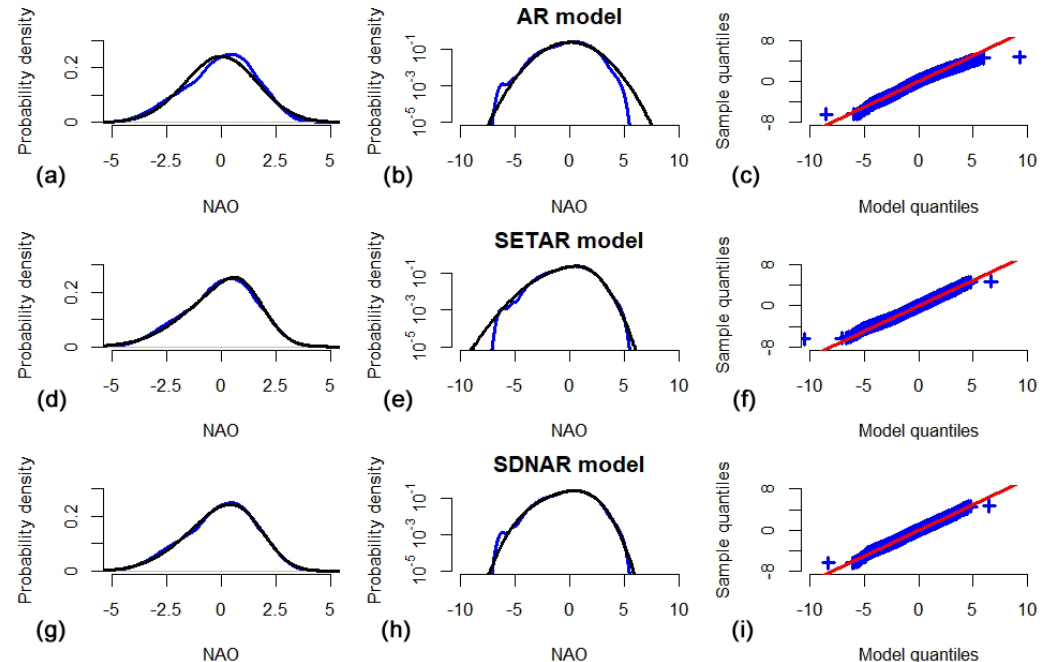
Figure 4. (a–c) Properties of the autoregressive (AR), (d–f) self-exciting threshold autoregressive models (SETAR) and (g–i) state-dependent nonlinear autoregressive models (SDNAR) models for the daily NAO winter index. The plots in the left and middle columns show the probability density function (PDF) of the daily NAO winter index (blue) compared to the PDF of simulated values (black) in standard scale (a, d, g) and logarithmic scale (b, e, h) . Panels (c) , (f) and (i) show Q–Q plots of the daily NAO winter index compared to the simulated